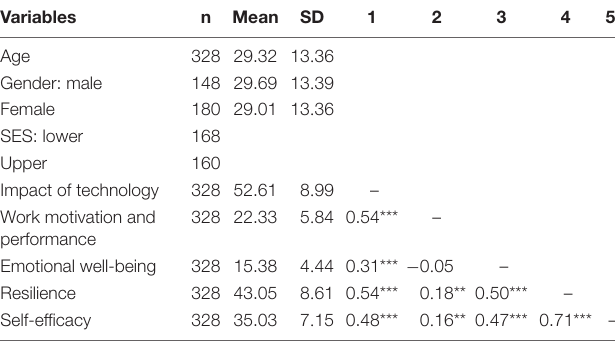
TABLE 2 | Means, standard deviations, and correlations for variables.